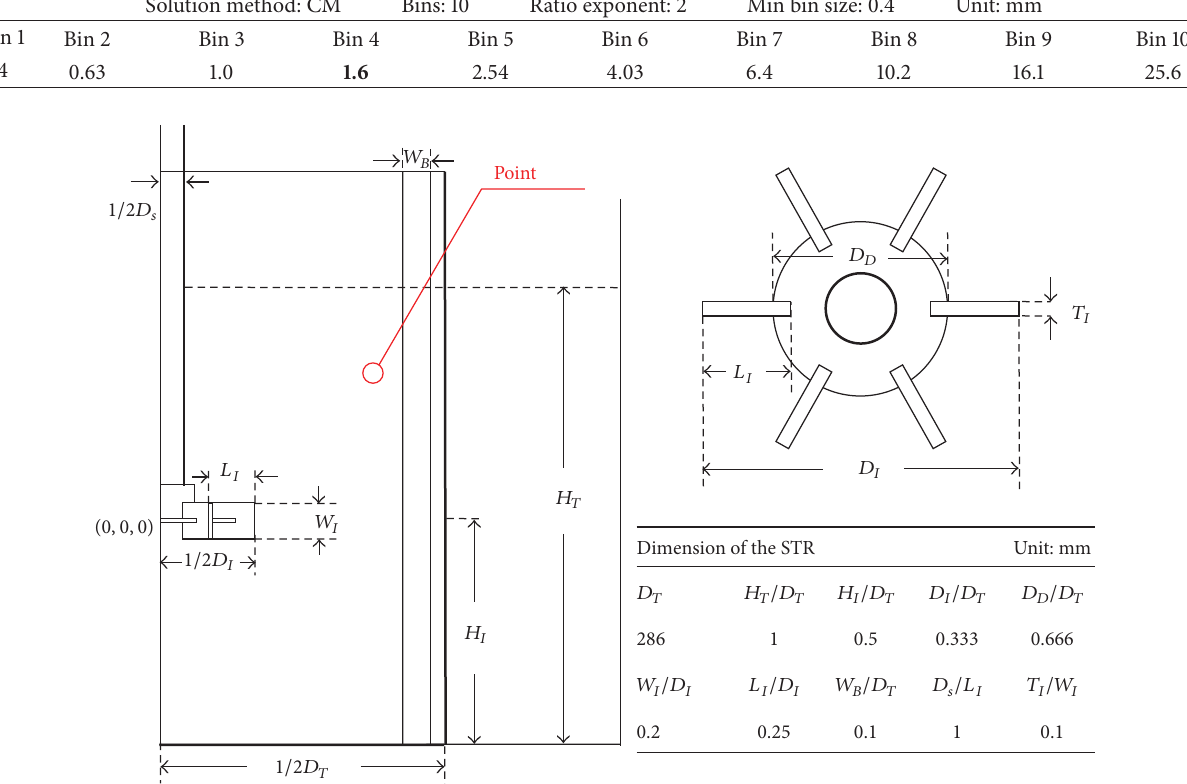
Figure 3: Dimension diagram of stirred tank reactor and Rushton turbine.